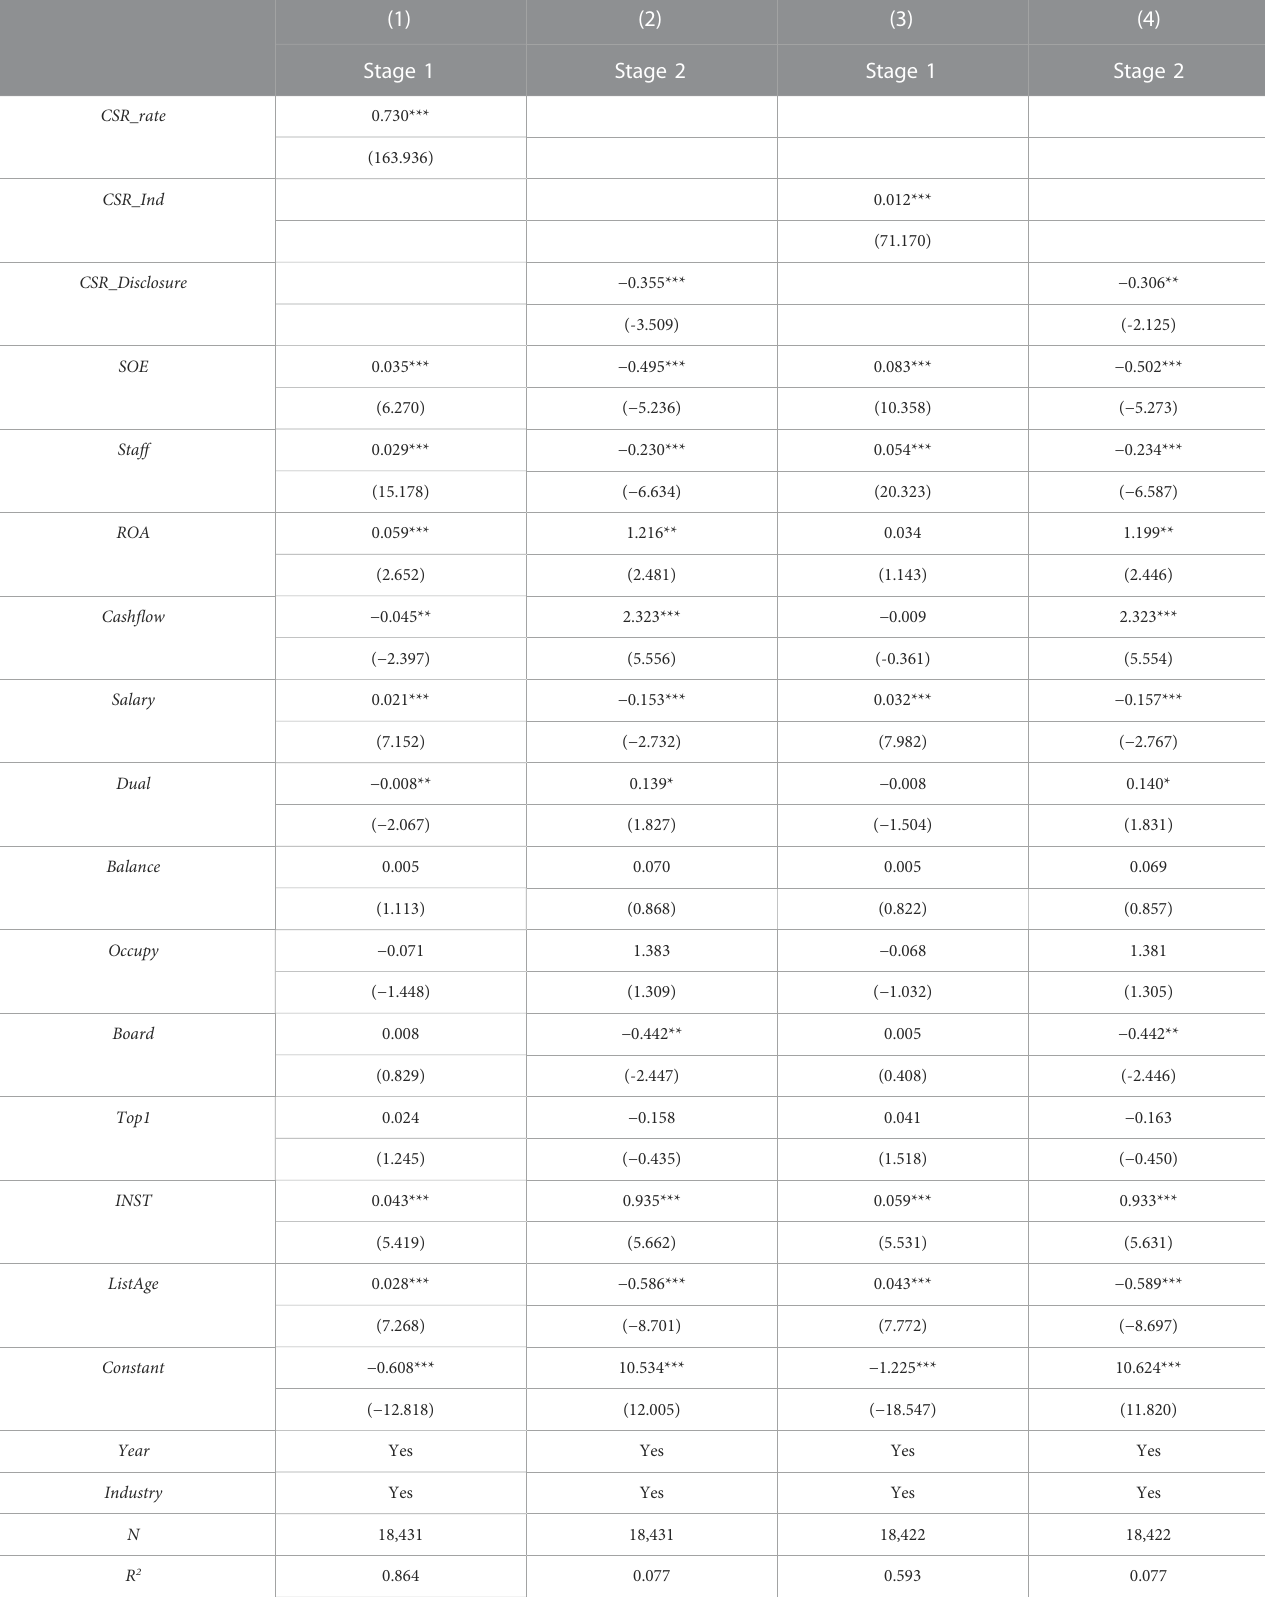
TABLE 9 2SLS regression